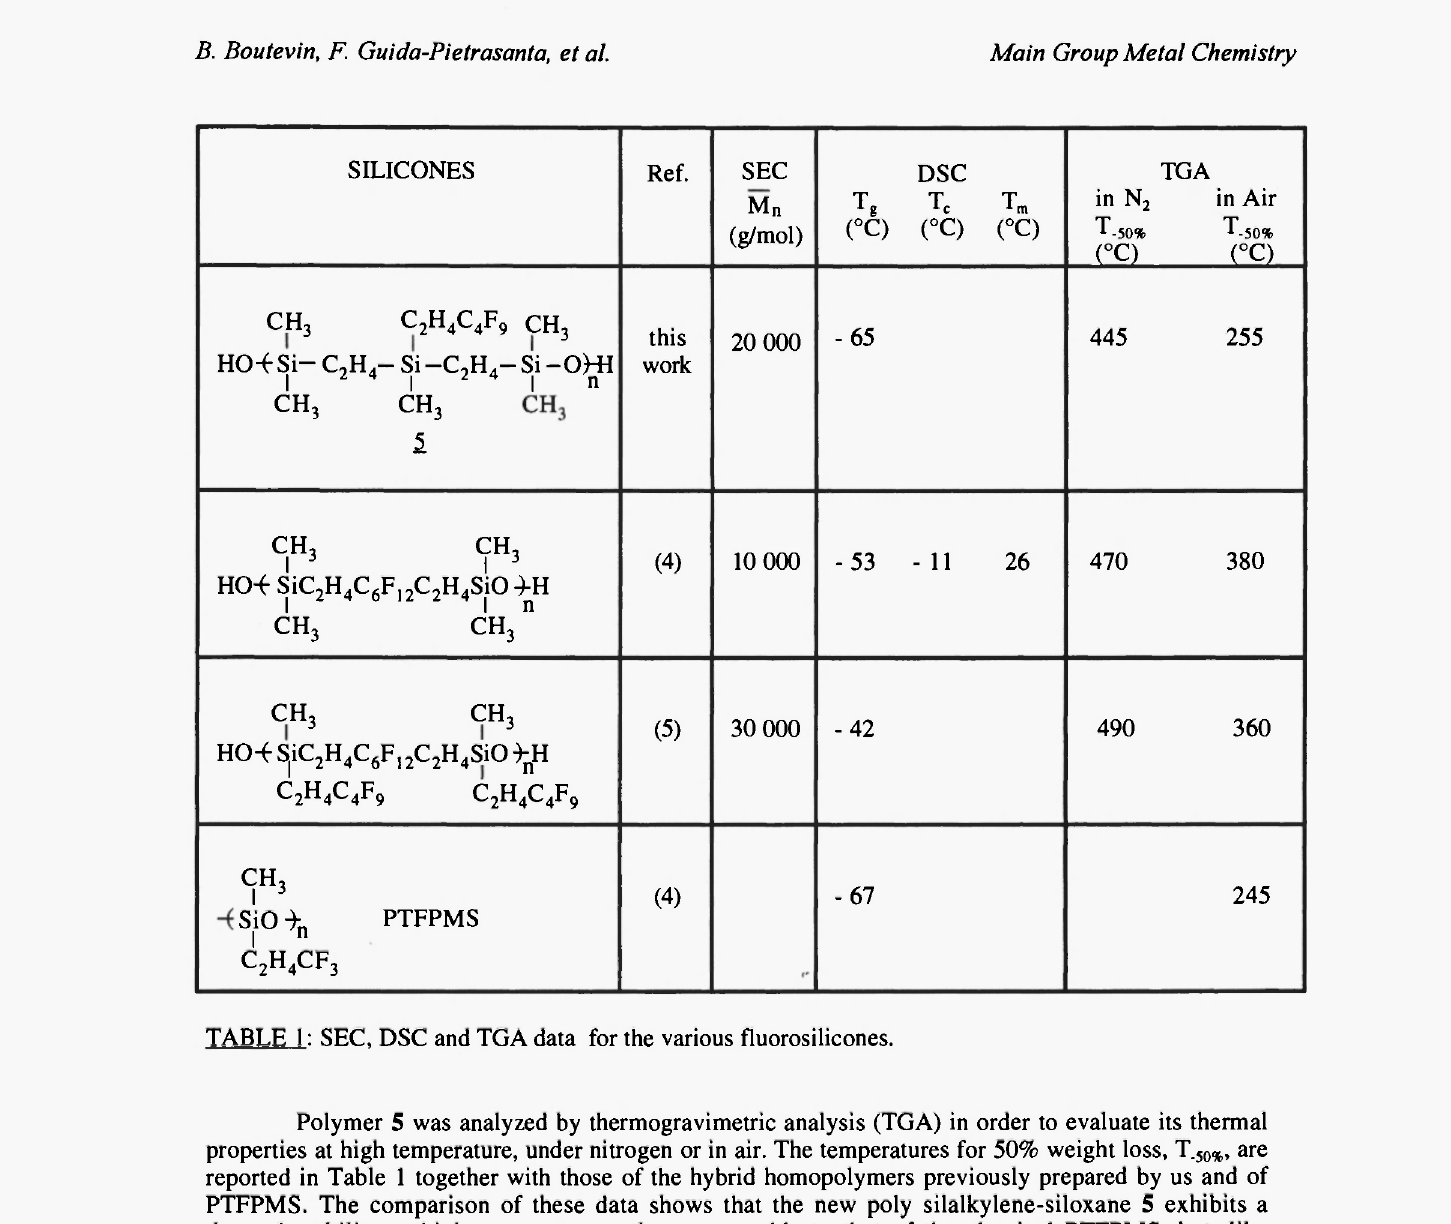
TABLE 1: SEC, DSC and TGA data for the various